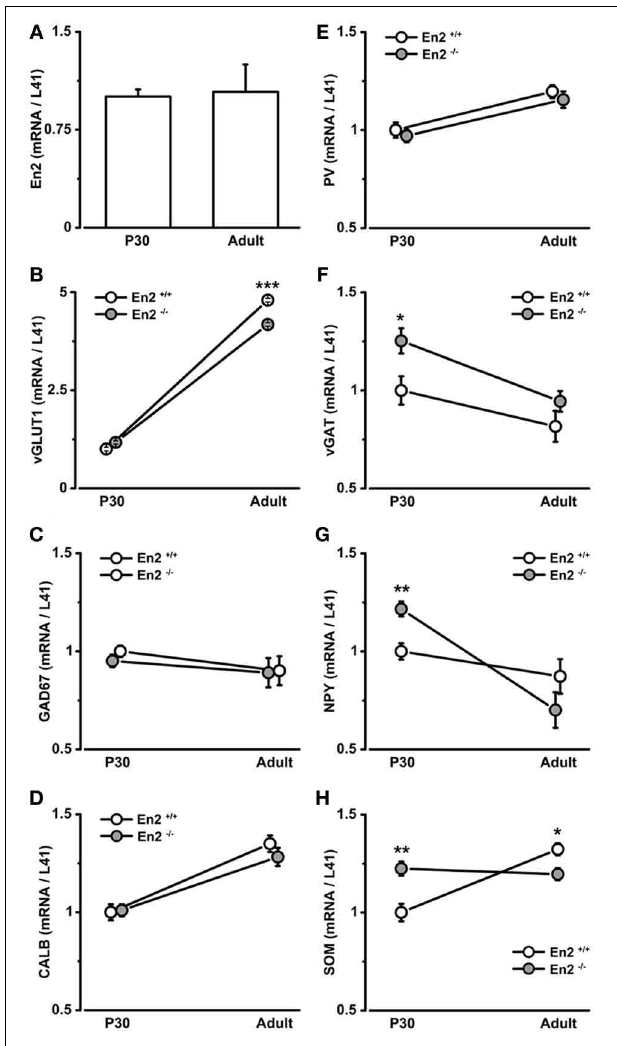
FIGURE 1 | mRNA expression of En2 and glutamatergic/GABAergic markers in the juvenile and adult visual cortex of En2 + / + and En2 − / − mice. (A–H) Relative mRNA expression level as obtained by quantitative RT-PCR performed on the visual cortex of P30 and adult En2 + / + (white) and En2 − / − (gray) mice. ( A , En2 ; B , vGLUT; C , GAD67; D , CALB; E , PV; F , vGAT; G , NPY and H , SOM). Values are expressed as each marker/L41 comparative quantitation ratios (mean ± s.e.m.). vGAT, NPY, and SOM mRNA levels were significantly higher in En2 − / − mice at P30, whereas vGLT and SOM mRNA levels were higher in adult En2 + / + mice (see text for details). Statistical significance: ∗ p < 0 . 05, ∗∗ p < 0 . 01, ∗∗∗ p < 0 . 001 ( En2 + / + vs. En2 − / − ). Abbreviations as in the